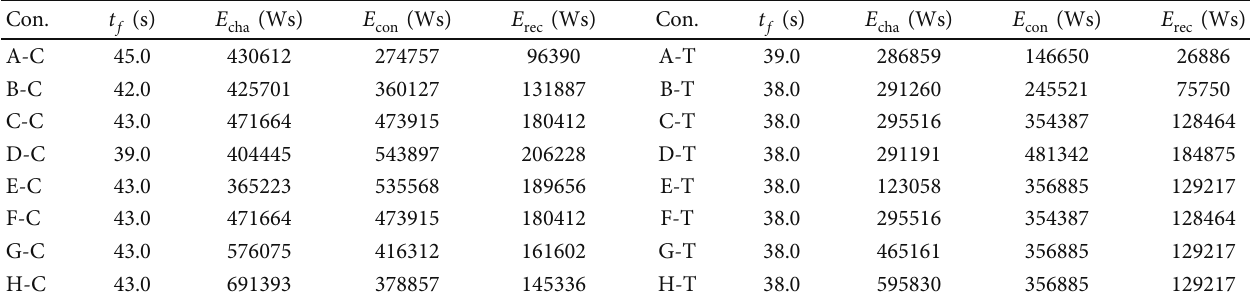
Table 5: Numerical results under eight scenarios.